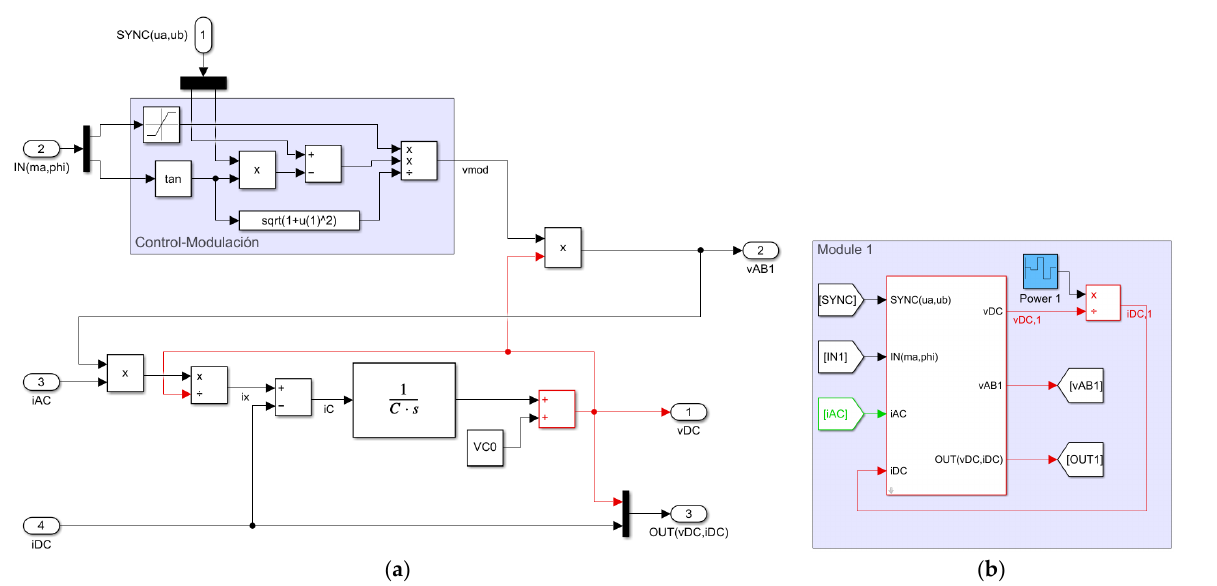
Figure 5. Model of a single PEB : ( a ) averaged model of PEB assuming null losses and efficiency of 100%, ( b ) PEB hierarchical view with input ports and output ports and given output power profile.